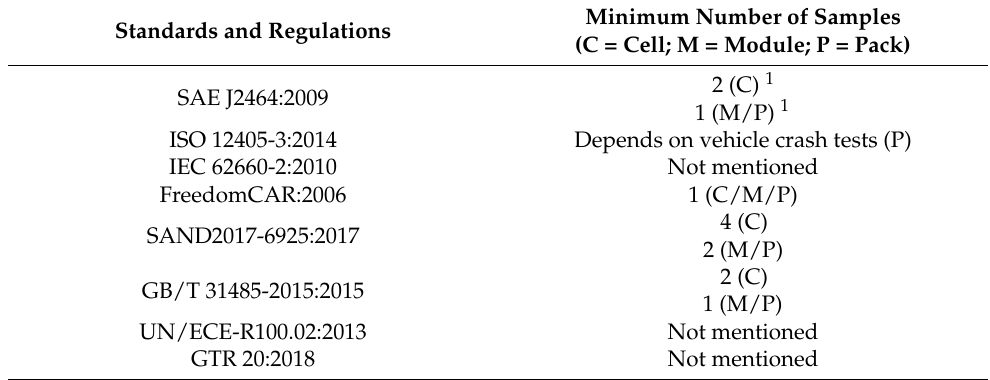
Table 8. Minimum number of samples needs to be tested as per different standards and